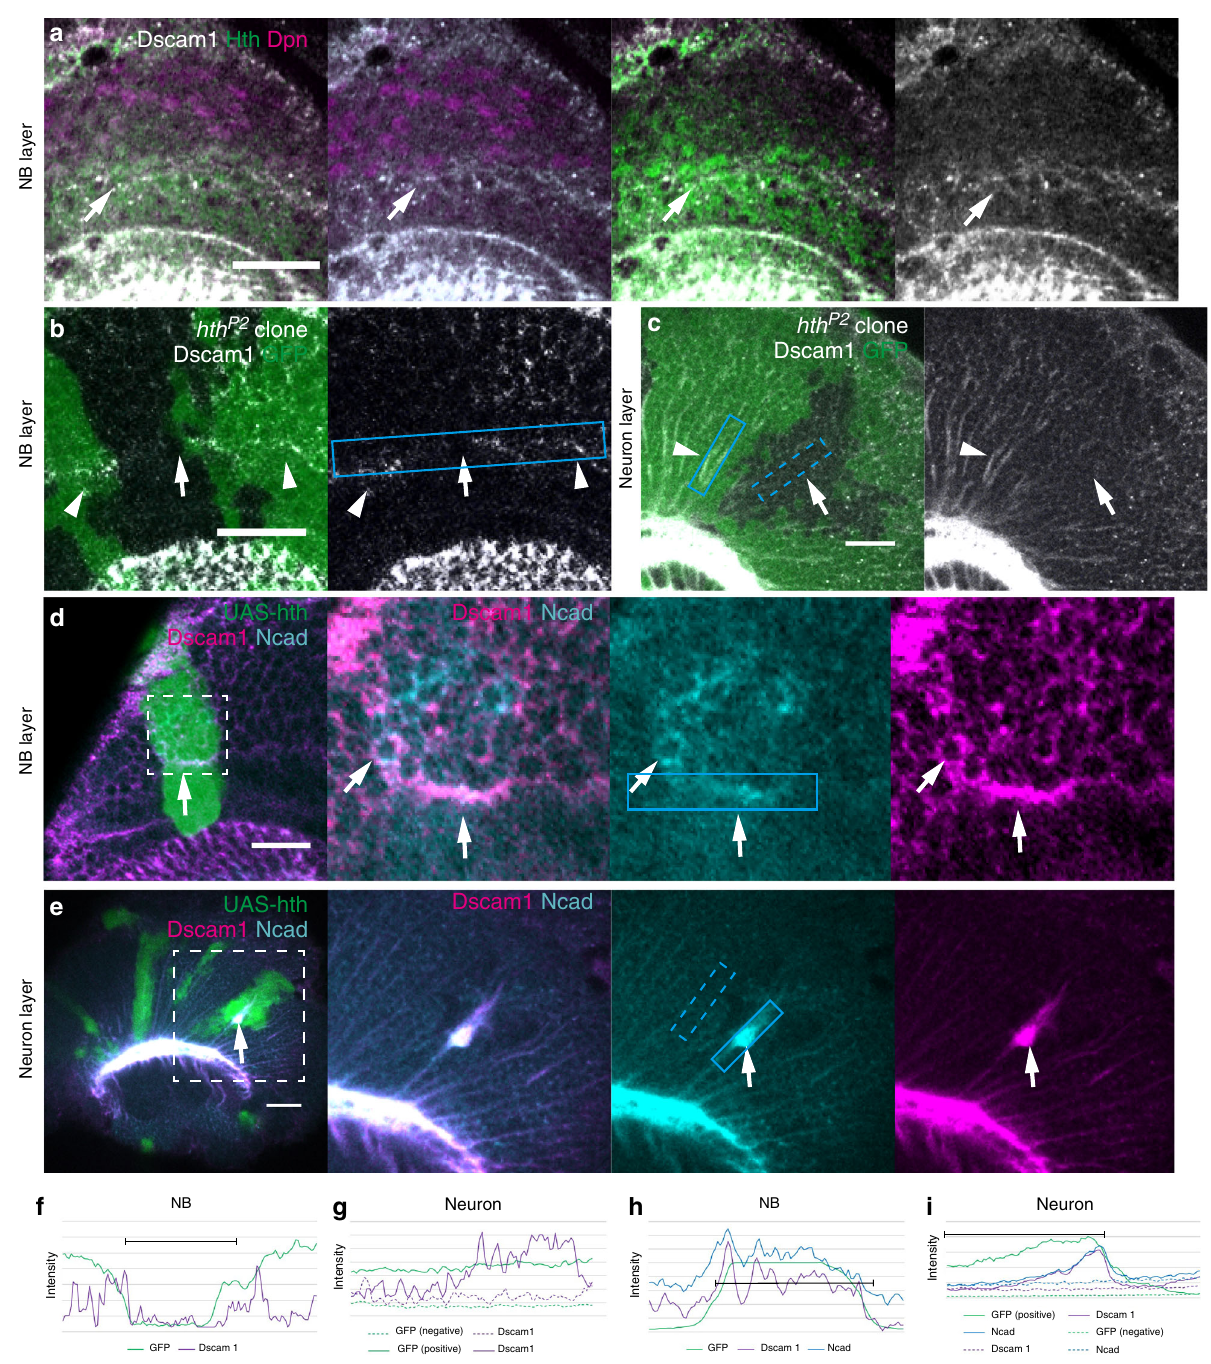
Fig. 4 Hth regulates the expression of Dscam1. Lateral views of L3 larval brains showing the NB ( a , b , d ) and neuron layers ( c , e ; see Fig. 1b). Dscam1 (white in a – c , magenta in d , e ). a Dscam1 expression overlaps with Hth (green) in NEs, and with Hth and Dpn (magenta) in NBs. b , c Background level of Dscam1 signal in hth mutant clones visualized by the absence of GFP (green; arrows) compared with the control cells (arrowheads). Pixel intensity of Dscam1 signal was uniformly enhanced throughout the image ( b ). d , e Ectopic Dscam1 upregulation in clones expressing hth visualized by GFP (green; arrows) under the control of Ay-Gal4 . Ncad (blue). The areas indicated by the dotted boxes are enlarged in the right panels. Scale bars indicate 20 μ m. f – i Quanti fi cation of signal intensity in the boxes in ( b – e ). Intensities in the dotted boxes are plotted with dotted lines. f , g Dscam1 signal is reduced in GFP- negative hth mutant clones ( b , c ). h , i Dscam1 signal is enhanced in GFP-positive hth expressing clones ( d , e ). Background signal was subtracted for Dscam1 ( f , h ). Experiment was independently repeated at least three times with similar results ( a – e ). Source data are provided as a Source Data fi le ( e , g , h , i multiple neurons, which is greater than the average distance compared projection patterns of neurites of the radial units in between two neurons (Fig. 1l). In contrast, Dscam1 mutant control and Dscam1 null mutant clones ( dscam 20 ; Fig. 5a – d). In control clones, neurites of a radial unit were defasciculated neurites were bundled in M0 layer and projected to the same or and projected to remote columns (distance = 50 μ m, n = 8; nearby columns (distance = 20 μ m, n = 10; Fig. 5b, c), suggesting Fig. 5a, c). Note that we measured the largest distance among that Dscam1 is responsible for lineage-dependent repulsion.